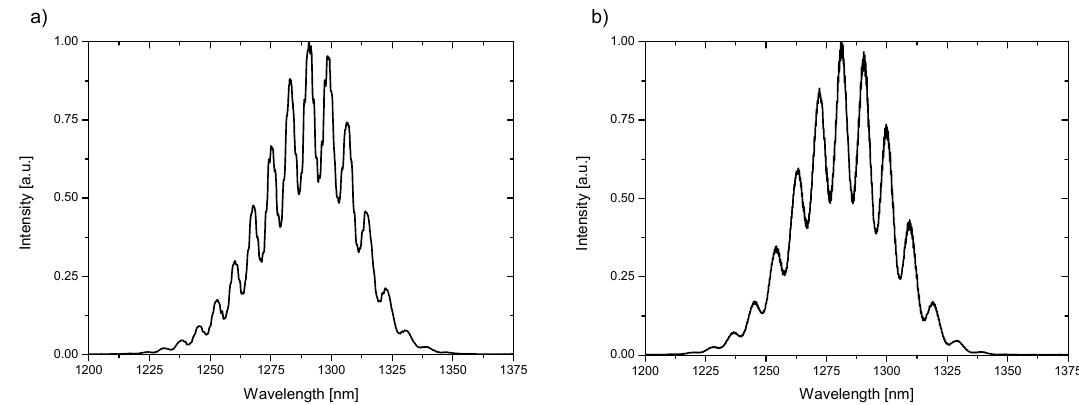
Figure 5. Spectra of liquid with refractive index n = 1.4 measured with a wavelength of 1290 nm ( a ) BD-NCD-Si, ( b ) ND-NCD-Si.